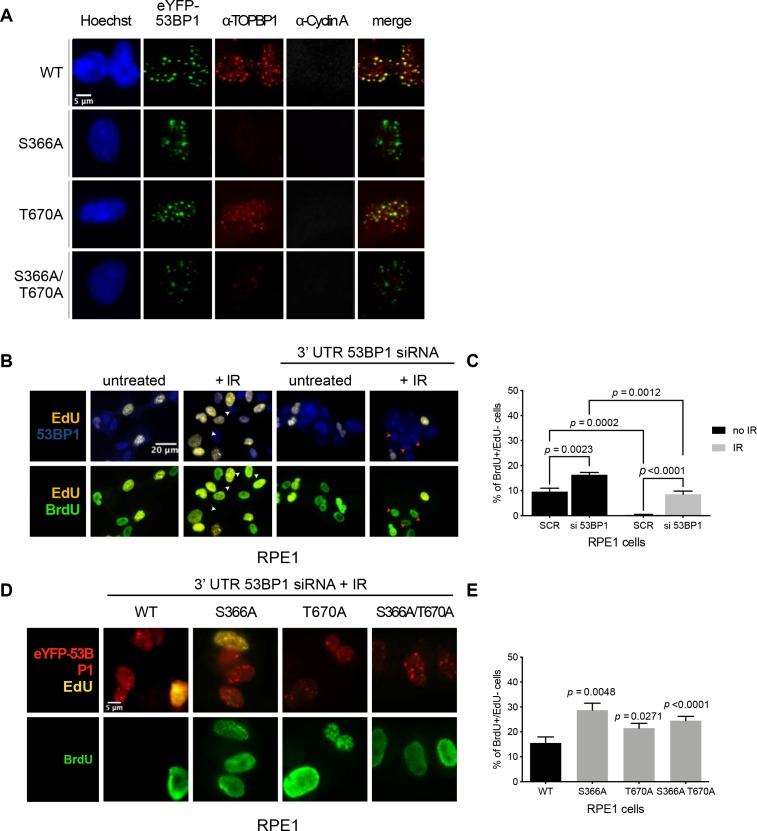
TOPBP1-53BP1 co-localization and G1/S Checkpoint defects in RPE1 cells.(A) Four hours after 9Gy IR, TOPBP1 foci co-localise with eYFP-53BP1 WT in stably transfected RPE1 cells depleted for endogenous 53BP1. Formation of co-localising TOPBP1 foci is greatly reduced in cells expressing eYFP-53BP1 S366A and T670A mutations, and the general distribution of TOPBP1 is more diffuse. The absence of substantial cyclin A immunofluorescence marks the nuclei of cells in G1. Scale bar, 10 µm. (B) G1/S checkpoint analysis. Incorporation of BrdU (green) in EdU negative RPE1 cells (yellow) indicates their S phase entry. Control irradiated cells (2Gy) show a robust G1/S checkpoint arrest, with no progress into S-phase (no BrdU incorporation, see white arrows). Progress into S-phase is not inhibited in 53BP1 knocked-down cells following IR (red arrows). Images were acquired with an IX70 Core DeltaVision microscope. (C) Statistical analysis of data of observed as in A. Bars represent the means of percentage of BrdU+/EdU- cells from more than 2000 cells per case with error bars as standard error of the mean. (D) 53BP1 knocked-down cells transfected with eYFP-53BP1 show a G1/S checkpoint following irradiation, while those transfected with 53BP1 in which one or both TOPBP1-binding phosphorylation sites Ser 366 and/or Thr 670 are mutated, progress into S-phase and incorporate BrdU. (E) As B, bars represent means of percentage of BrdU+/EdU- cells from more than 500 eYFP-53BP1 transfected cells per case with error bars as standard errors of the mean. Kruskal-Wallis test corrected with a Dunn’s multiple comparison was done. Adjusted p values are displayed when significant differences are observed.